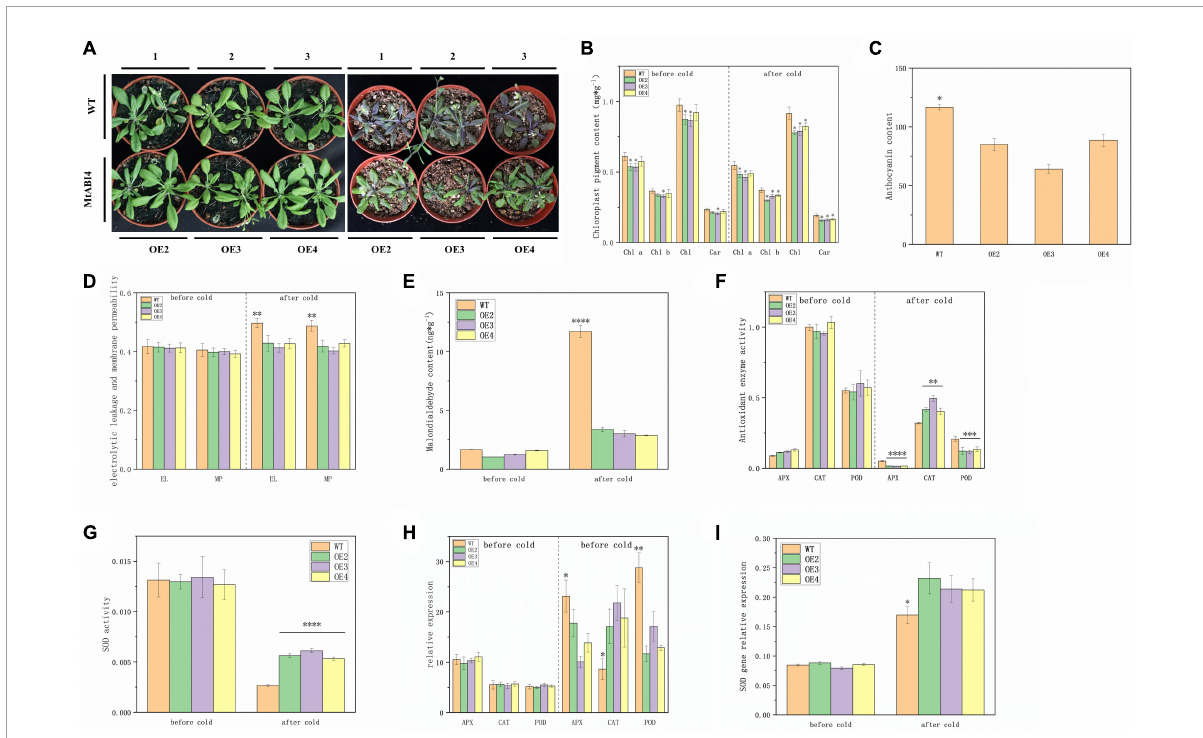
FIGURE3 Plant growth status, physiological characteristics, and the expression of antioxidant enzyme genes at low temperatures. Panel (A) represents the growth condition of wild-type and transgenic plants before the low-temperature treatment and after the 5-day low-temperature treatment. Panels (B–E) represents the content of chloroplast pigments, anthocyanin, electrolytic leakage, membrane permeability, and malondialdehyde. Panels (F,G) represent the activity of APX, CAT, POD, and SOD. Panels (H,I) represent the expression of these antioxidant enzyme genes. The values are means ± SD ( n = 3). ∗ , in graphs, indicates significant differences in the means at p < 0.05 between each level in transgenic lines and WT plants, and ∗∗ , ∗∗∗ , and ∗∗∗∗ , in graphs, indicate significant differences in the means at p < 0.01, p < 0.001, and p < 0.0001,